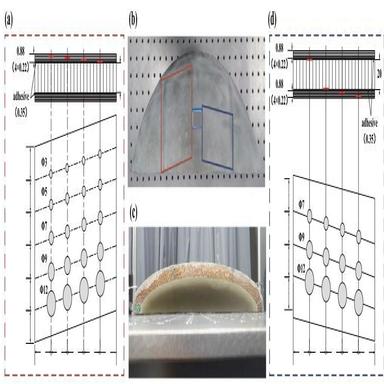
The schematic diagram of scanning strategy.